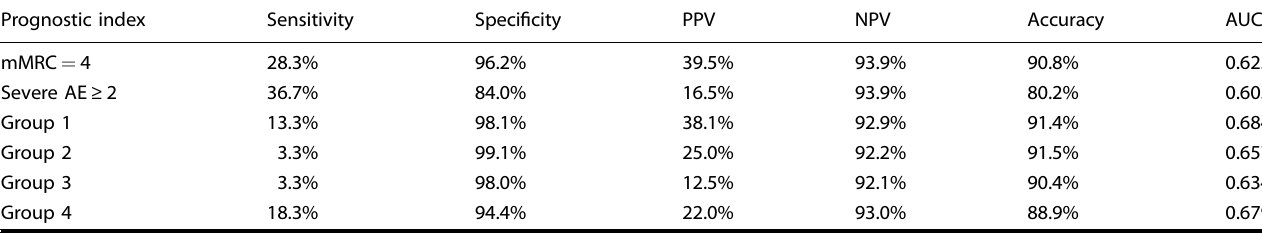
Table 2. Predictive accuracy of different recommended palliative care indices for 1-year mortality.